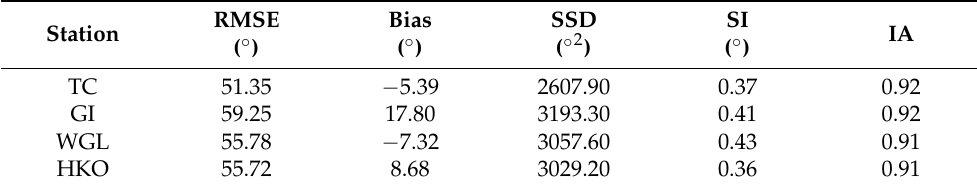
Table 6. Summary of the error indicators for the wind direction simulation.